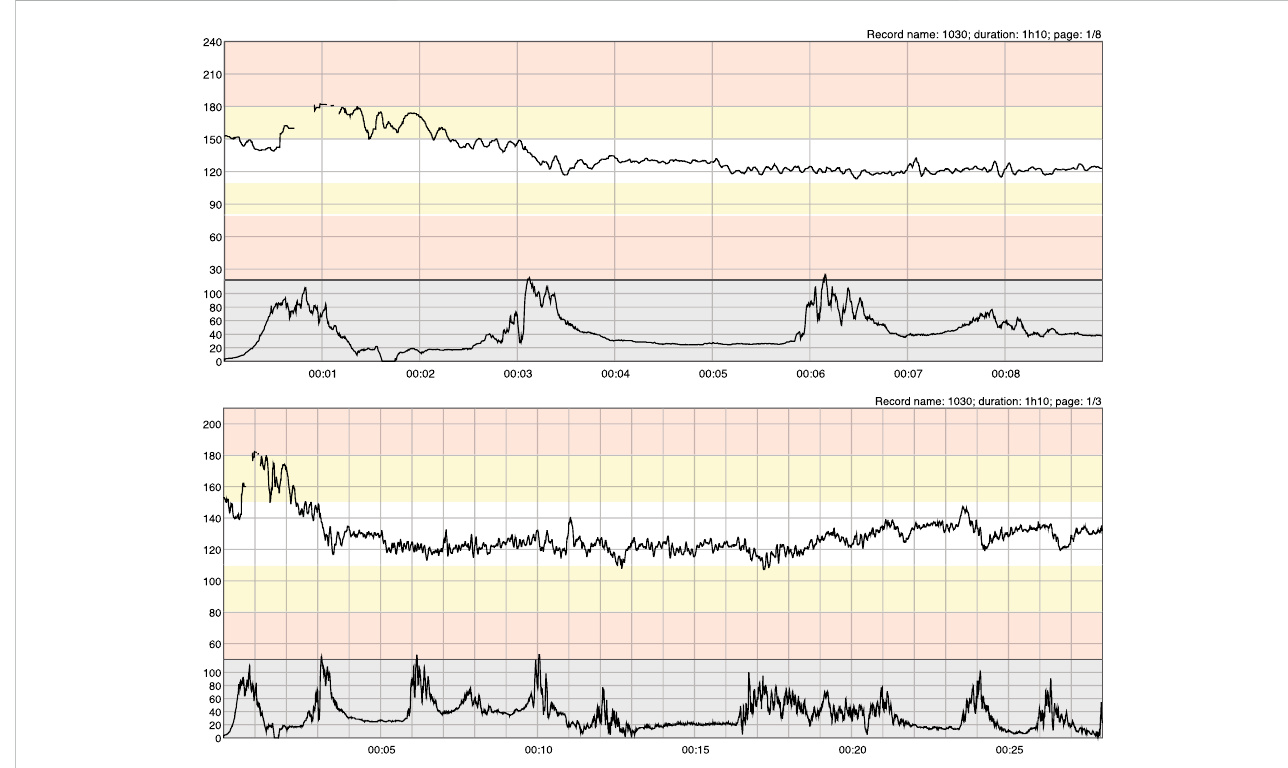
FIGURE 1 A segment of CTG recording from an open access intrapartum CTG database [described in (Chudá č ek et al., 2014)] in US (top two plots) and in EU (bottom two plots) paper formats,